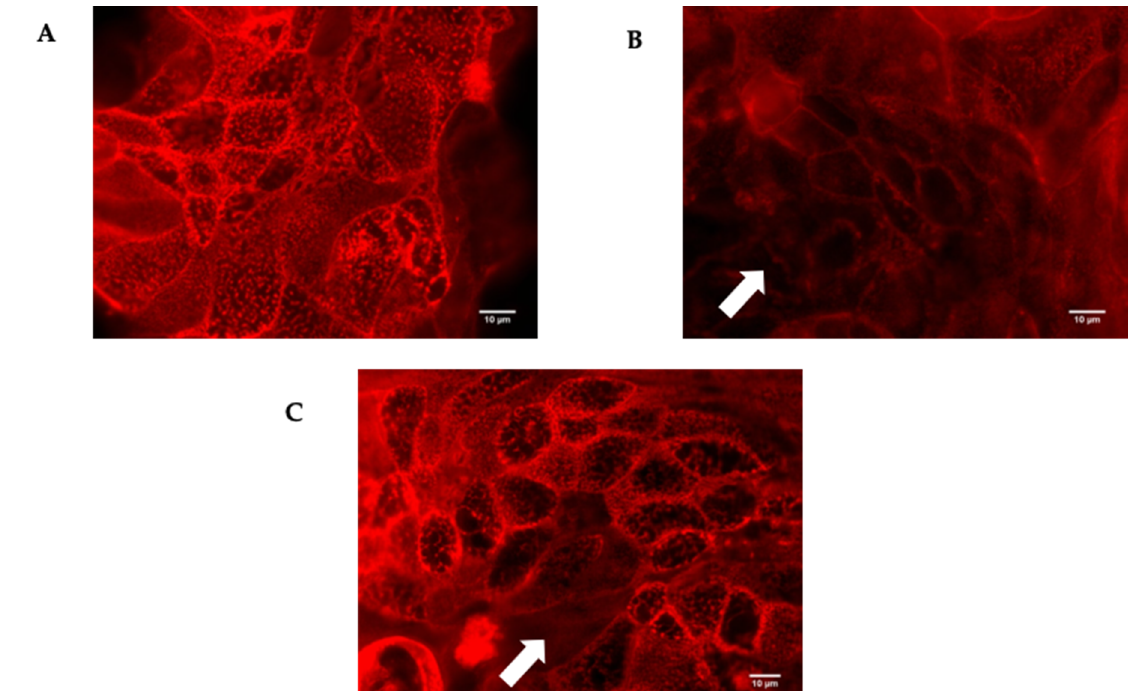
Figure 6. TRITC-phalloidin staining (red) of cell junction’s of the cell line HT29-MTXE12. No colonized cells ( A ), and after 4 h of colonization with P. dorei PtF D16P1 ( B ) and B. uniformis PtF D3Pch2 ( C ). The white arrow indicates evidence of the cell junction’s disruptions after the contact with P. dorei PtF D16P1 and B. uniformis PtF D3Pch2 in comparison with the undisrupted cell junctions of the control monolayers.